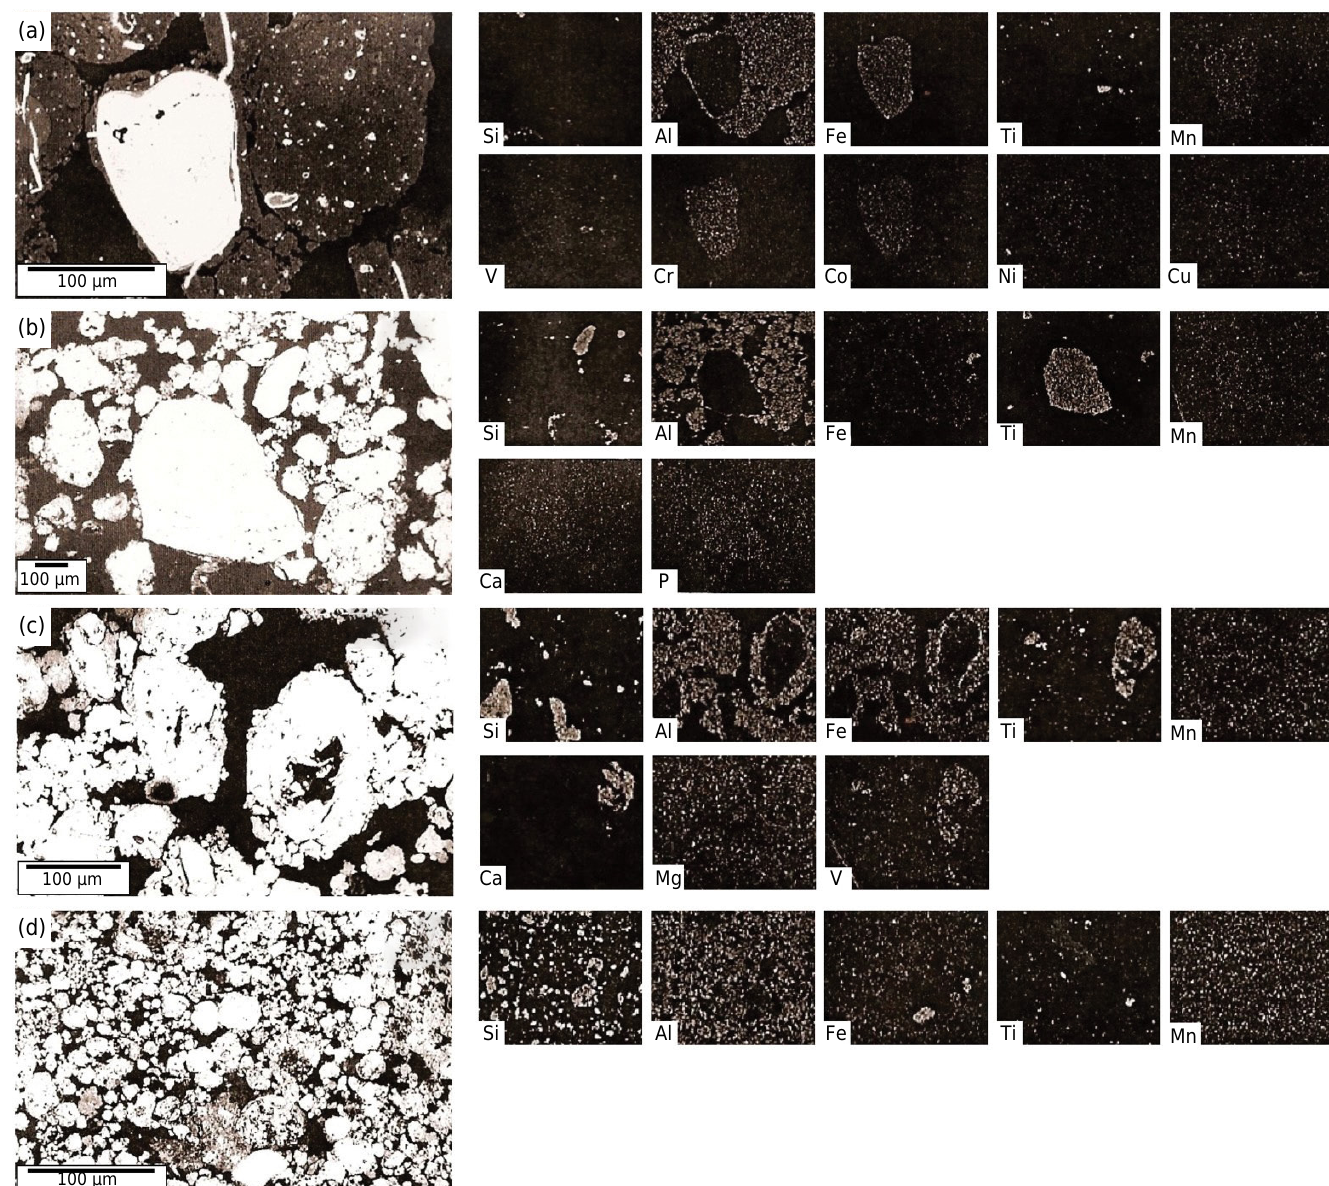
Figure 8. Scanning electron microscope photomicrographs and EDS microchemical maps of the Bw 2 horizon (a and b) in the P 4 - Geric Acric Gibbsic Ferralsol (Clayic, Dystric), and of the Bw 2 horizon (c and d) in the P 5 - Acric Rhodic Ferritic Ferralsol (Clayic, Dystric, Humic); Patrocínio topolithosequence. Fe/Cr-rich alteromorphs (a) and Ti minerals occurring as inclusions in the microaggregates (b), Ti-rich alteromorphs/perovskite (c), and Ti/Fe grains